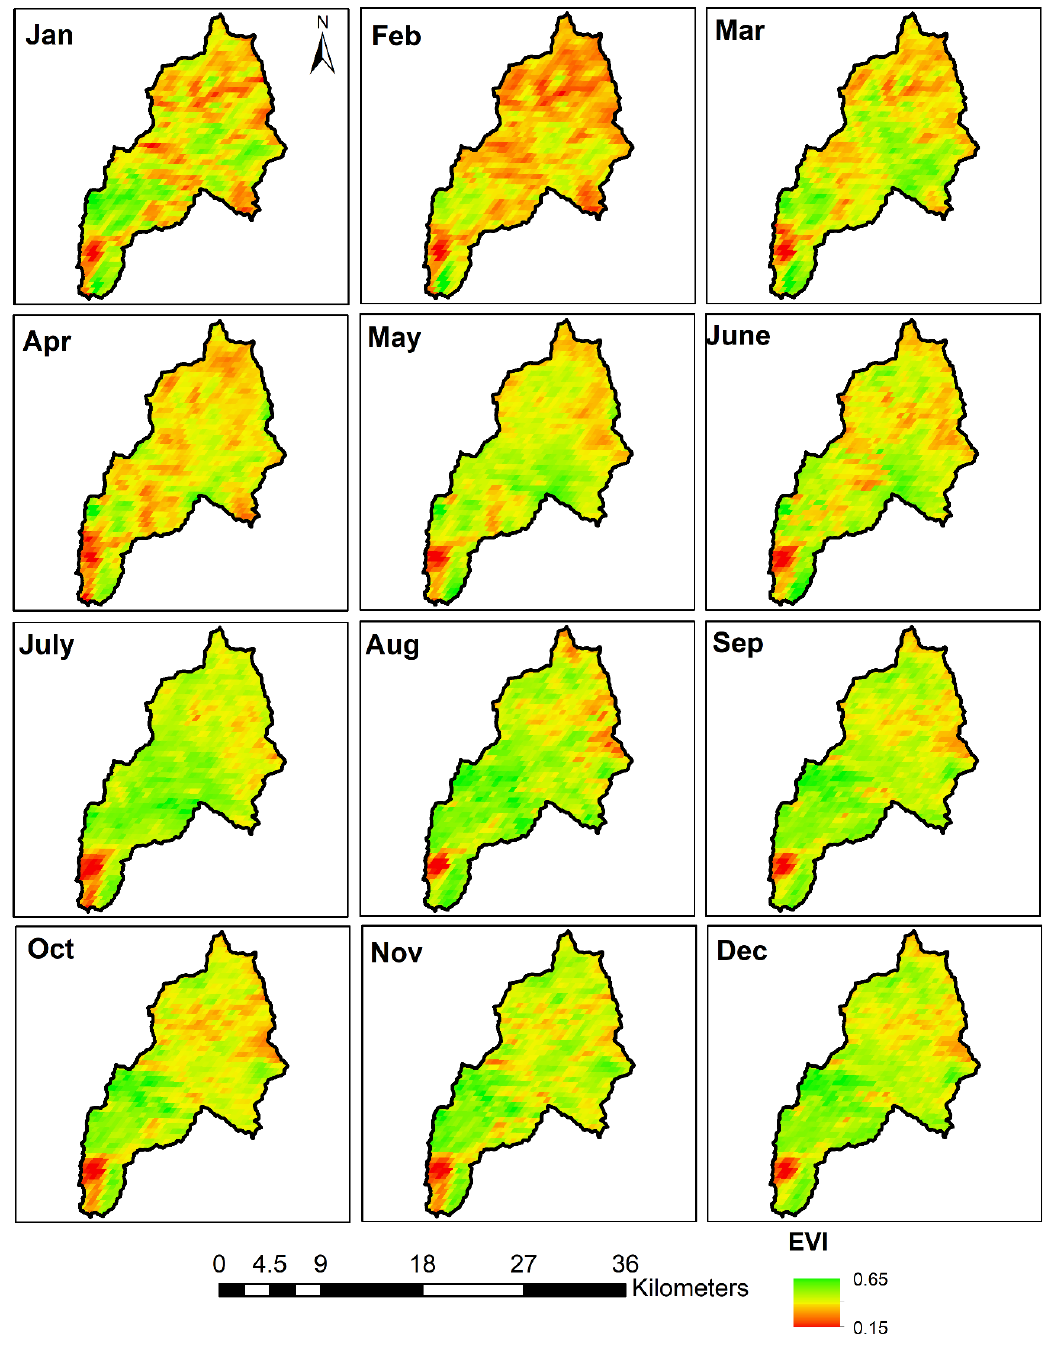
Figure 7. Mean monthly spatial variations of EVI for the twenty-year period (2001–2020) for the UKR Basin.